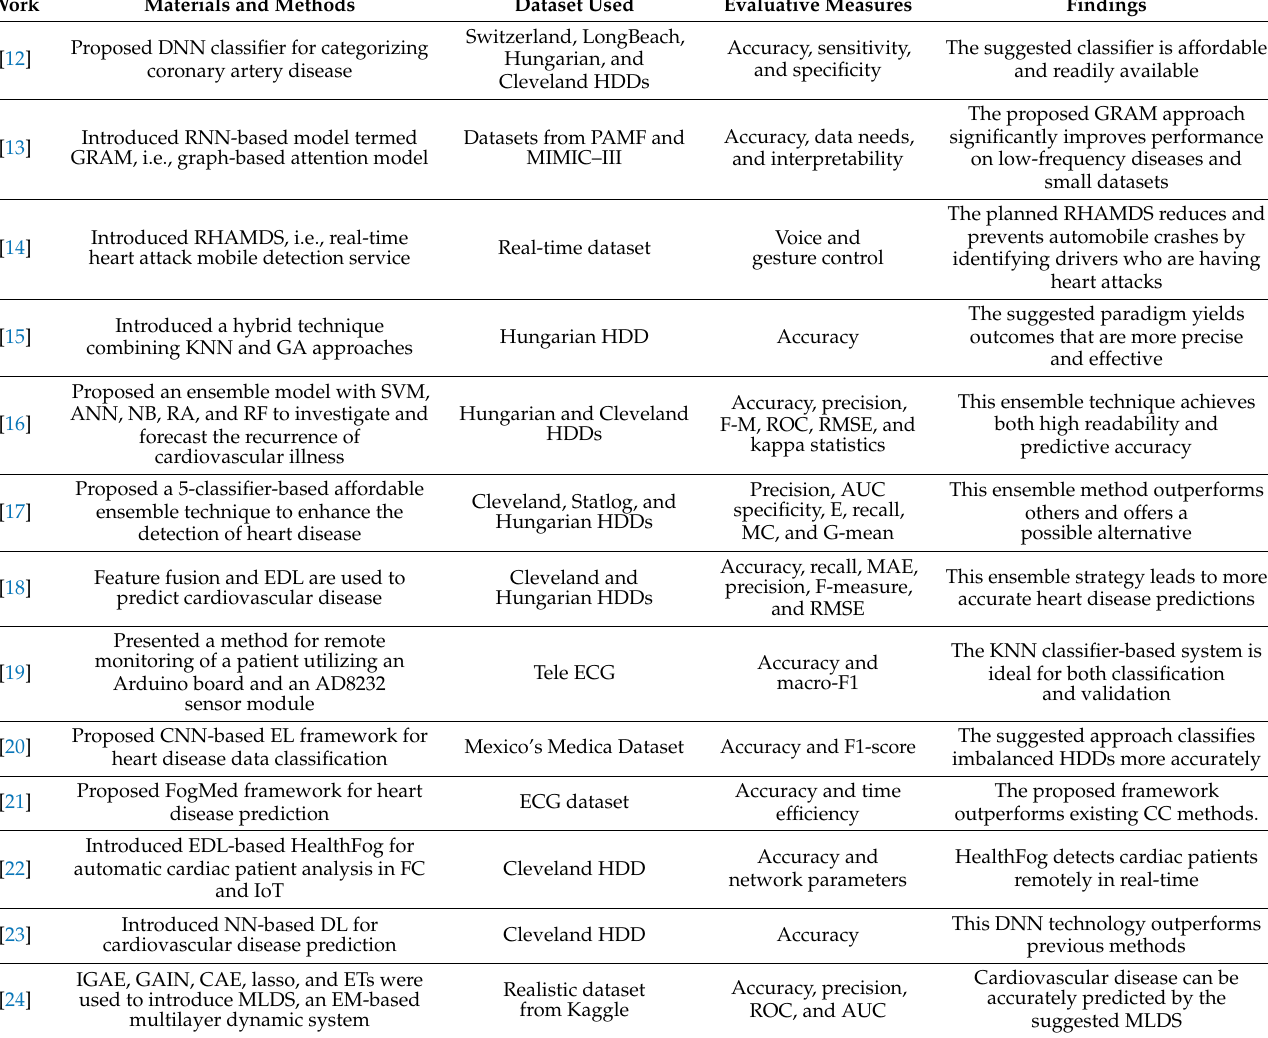
Table 1. A summary of some state-of-the-art works that are deemed to be